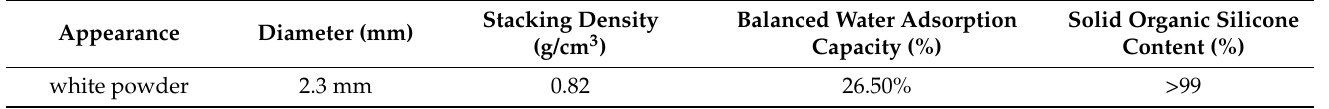
Figure 1. Appearance of the dehumidizer. Table 3. Dehumidifier